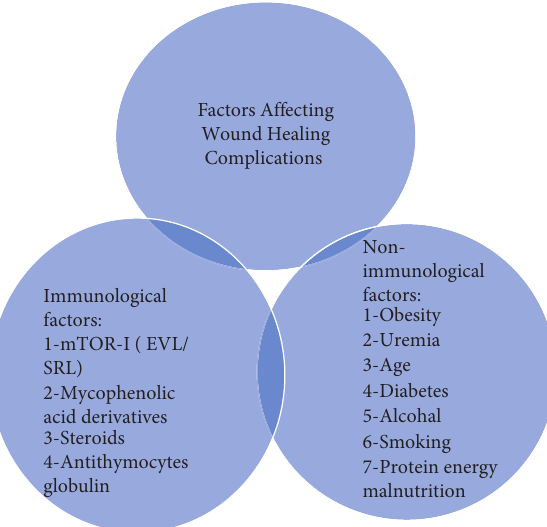
Figure 1: Factors associated with wound healing